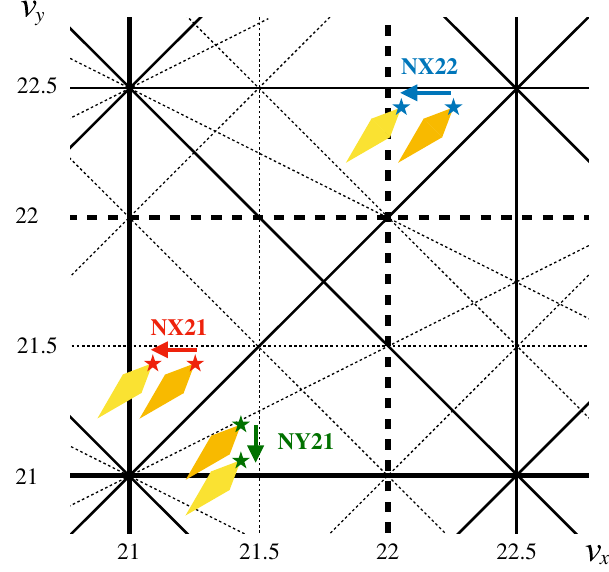
FIG. 2. The operation points set in the experiments (shown as stars), the tune spreads, and the major resonance lines have been plotted. Several operation points were chosen in the range of ð ν x ; ν y Þ ¼ ð 21 . 25 – 21 . 08 ; 21 . 43 Þ for the NX21 experi- ment, ð 21 . 43 ; 21 . 21 – 21 . 07 Þ for the NY21 experiment, and ð 22 . 25 – 22 . 05 ; 22 . 43 Þ for the NX22 experiment. The space- charge-induced structure resonances have been plotted as solid lines and the other major resonances have been plotted as dotted lines.